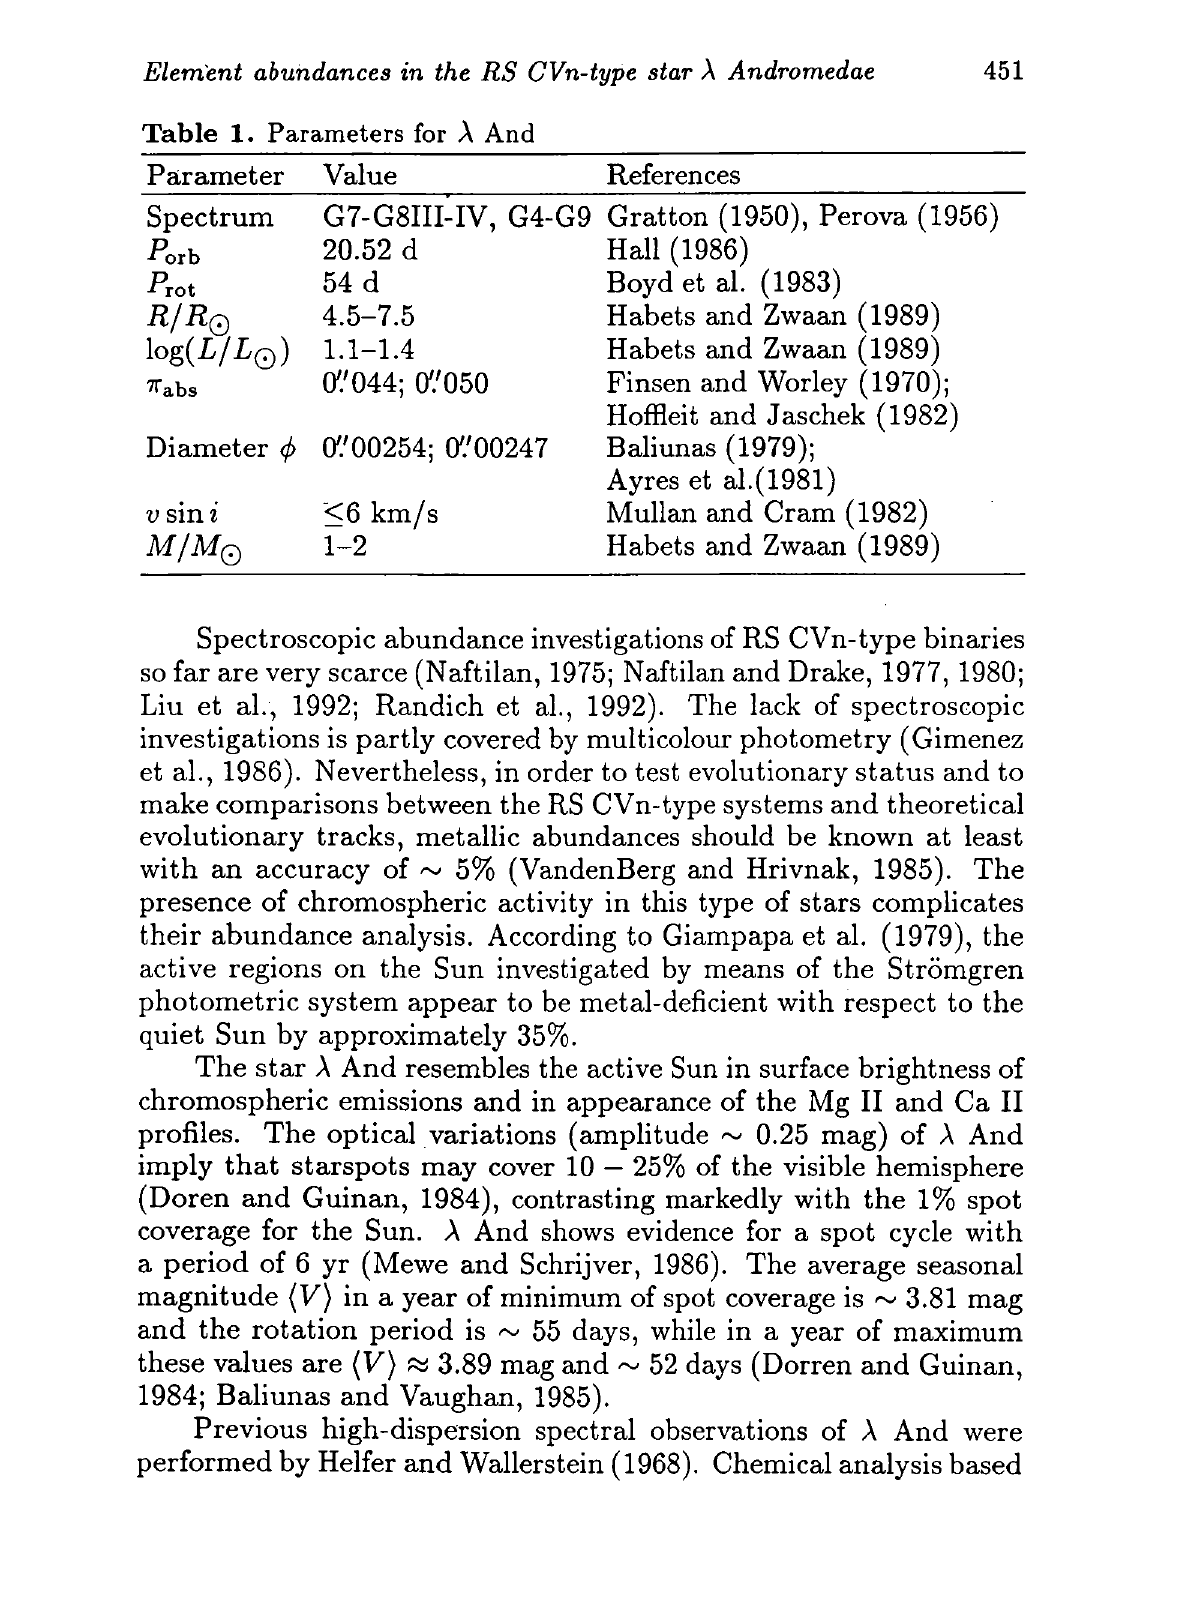
Table 1. Parameters for A And